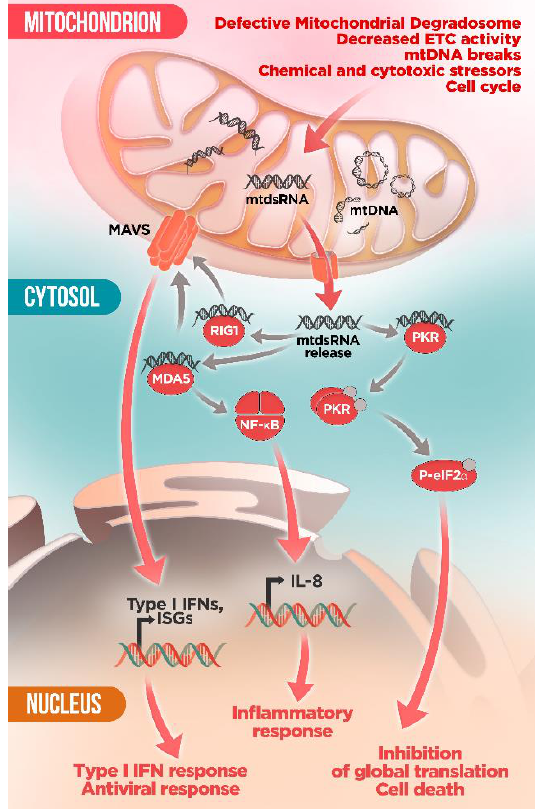
Figure 3. mtdsRNA-activated immune pathways. Dysfunctional mitochondria can accumulate mtdsRNA intermediates, either as a consequence of mitochondrial defects or due to external stimuli. Once released into the cytosol, mtdsRNA binds to the immune sensors MDA5 and RIG1, eliciting interferon type I response via MAVS. mtdsRNA can also bind and activate the antiviral kinase PKR, leading to phosphorylation of eIF2α and inhibition of global translation or cell death under sustained PKR activation. PKR